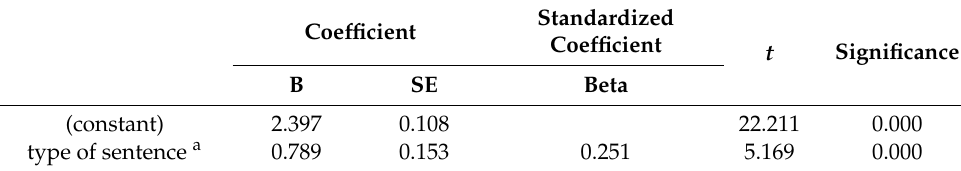
Table 5. Result of Study